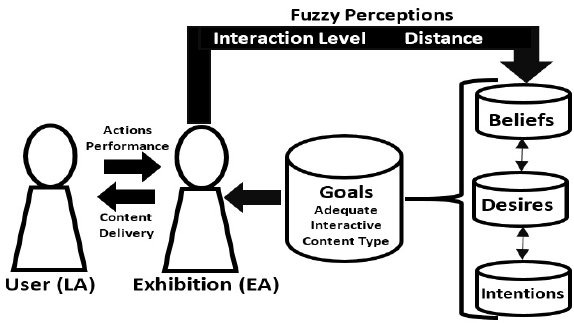
Figure 5. Exhibition (educator BDI agent) rationalization. The figure illustrates the rationalization process elements: the beliefs, desire, and intentions which are key to obtain the goals—in this case, to deliver the adequate interactive